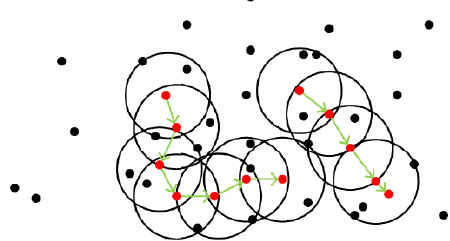
Figure 1. Schematic diagram of DBSCAN segmentation